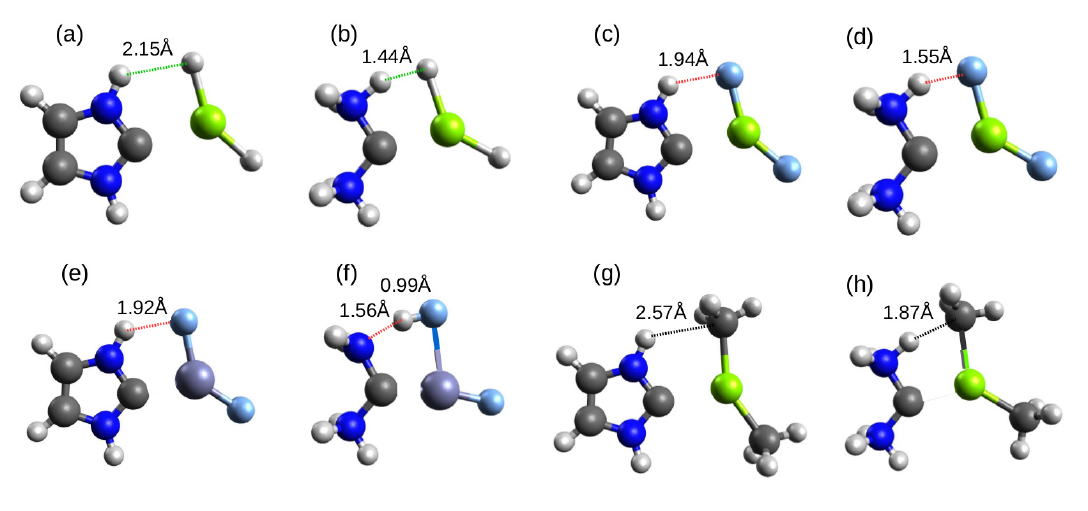
Figure 13. Structures of selected dimers containing certain intermolecular interactions accompanying the C · · · M bond: ( a ) imidazol-2-ylidene · · · MgH 2 , ( b ) (NH 3 ) 2 C · · · MgH 2 , ( c ) imidazol-2-ylidene · · · MgF 2 , ( d ) (NH 3 ) 2 C · · · MgF 2 , ( e ) imidazol- 2-ylidene · · · ZnF 2 , ( f ) (NH 3 ) 2 C · · · ZnF 2 , ( g ) imidazol-2-ylidene · · · MgMe 2 , ( h ) (NH 3 ) 2 C · · · MgMe 2